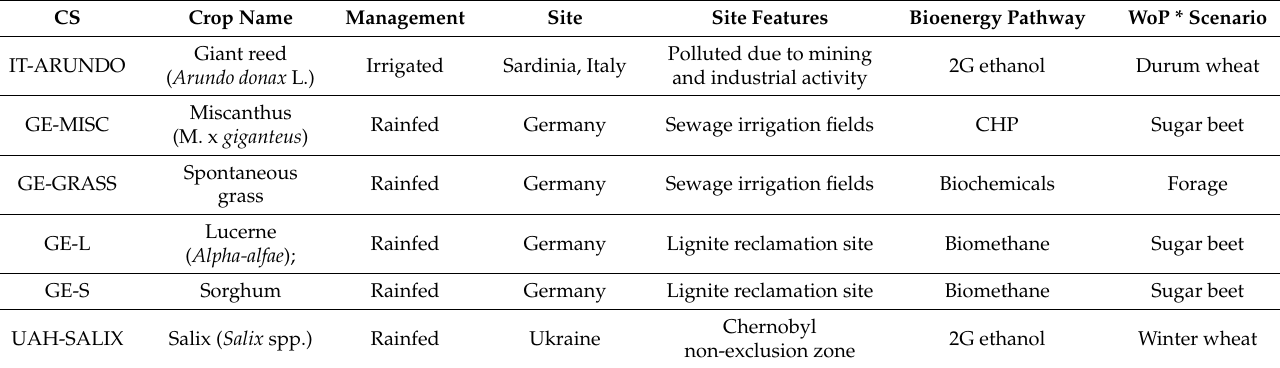
Table 1. Selected crops for potential cultivation on under-utilized, marginal and/or contaminated (MUC) land. CS Crop